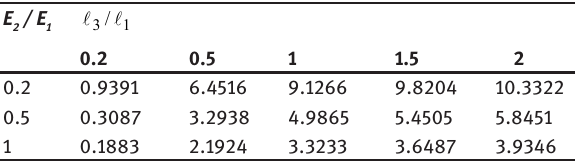
Table 3: The influence of the ratio 2 1 / E E on the values of the